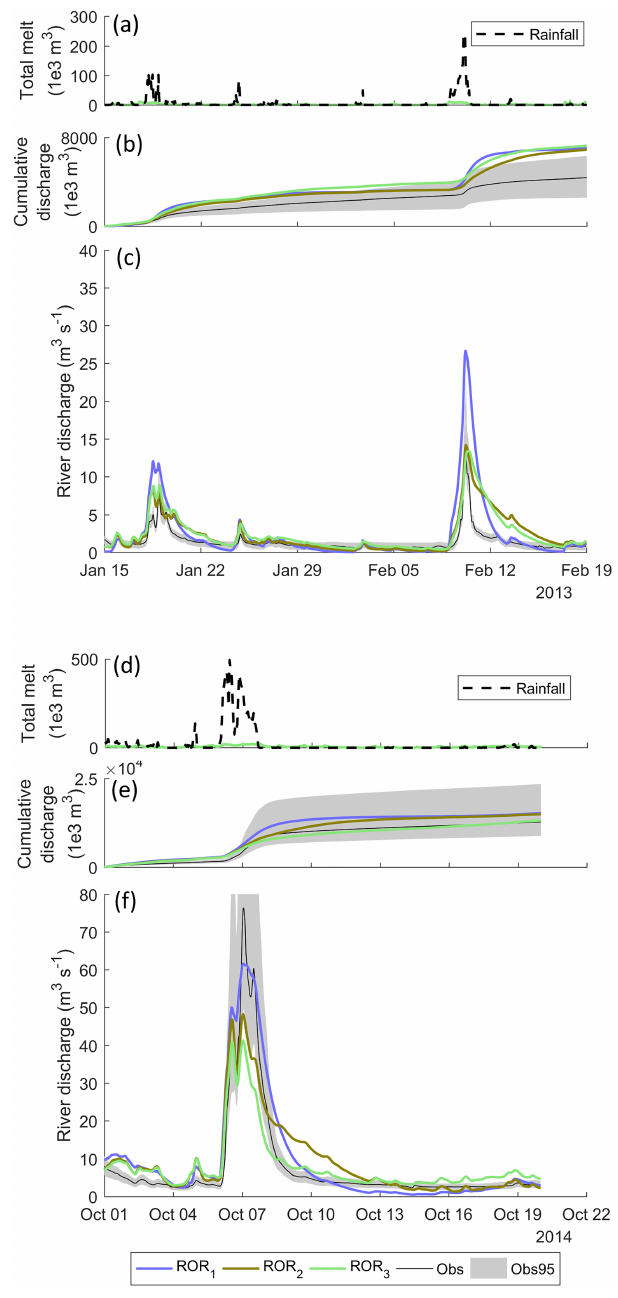
Figure 16. Simulation time series using the three different run-off- routing model structures in combination with the TIM 1 melt model structure including simulated total melt and rainfall (a) , cumula- tive river discharge (middle) and river discharge time series (bot- tom) for January and February 2013 (a, b, c) and the October 2014 flood (d, e, f)